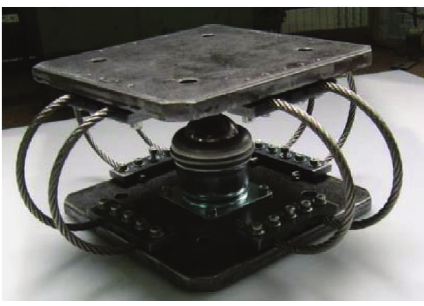
Figure 5: Isolator prototype [8].